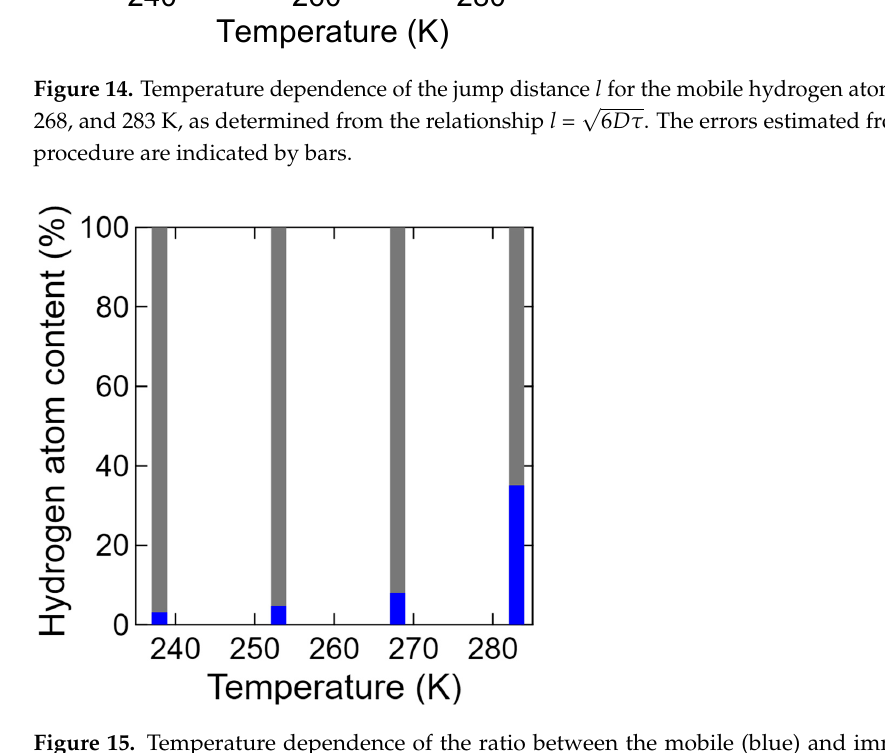
Figure 15. Temperature dependence of the ratio between the mobile (blue) and immobile (gray) hydrogen atoms at 238, 253, 268, and 283 K, as determined from Equations (5) and (6).